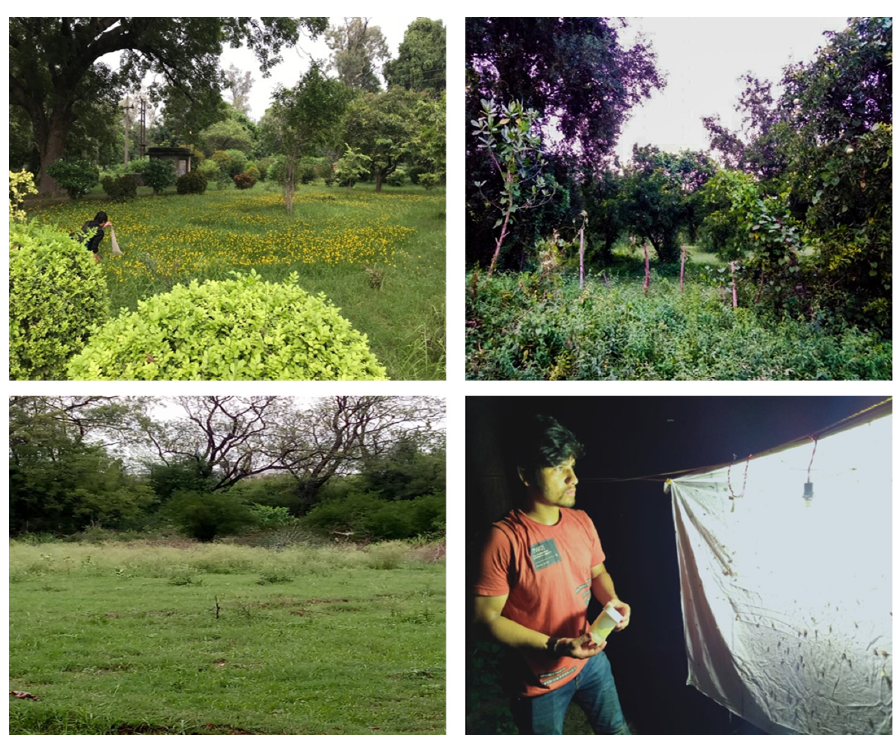
Figure 2. Habitat surrounding the various study sites where sampling was conducted during the surveys. (Top left: AF, Top Right: AT, Bottom Left: IG, Bottom Right: Collections by Light